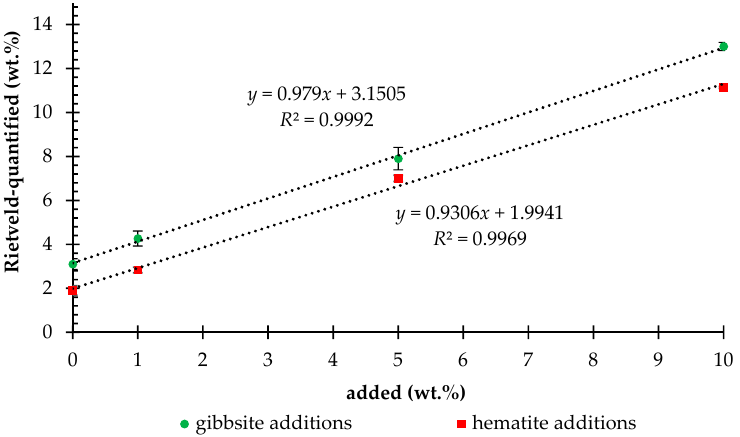
Figure 7. Mixture additions of gibbsite for the sample BRA0.5m and hematite for the sample BRA13m.